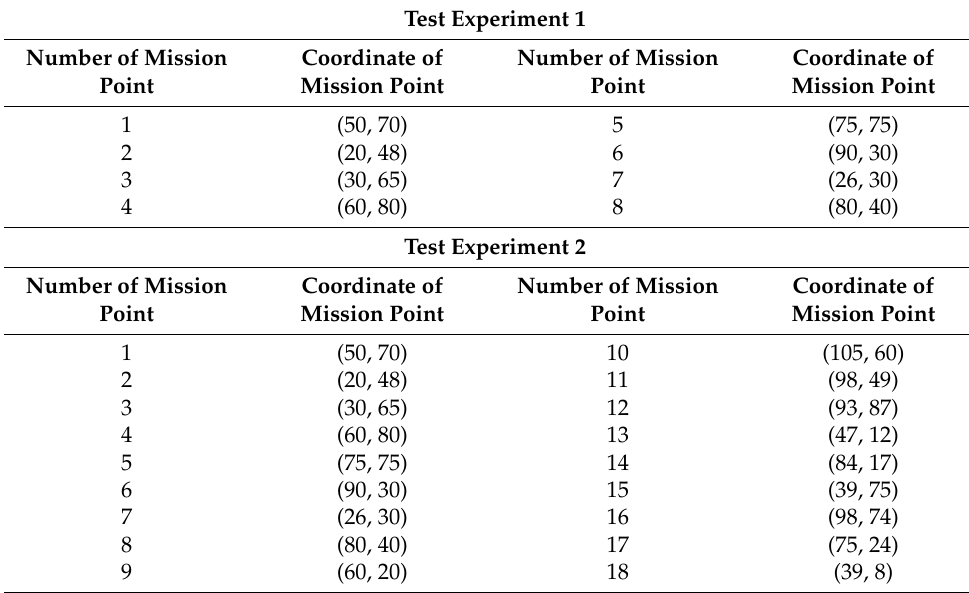
Table 4. Coordinates of mission point in the AGA evaluation experiment.